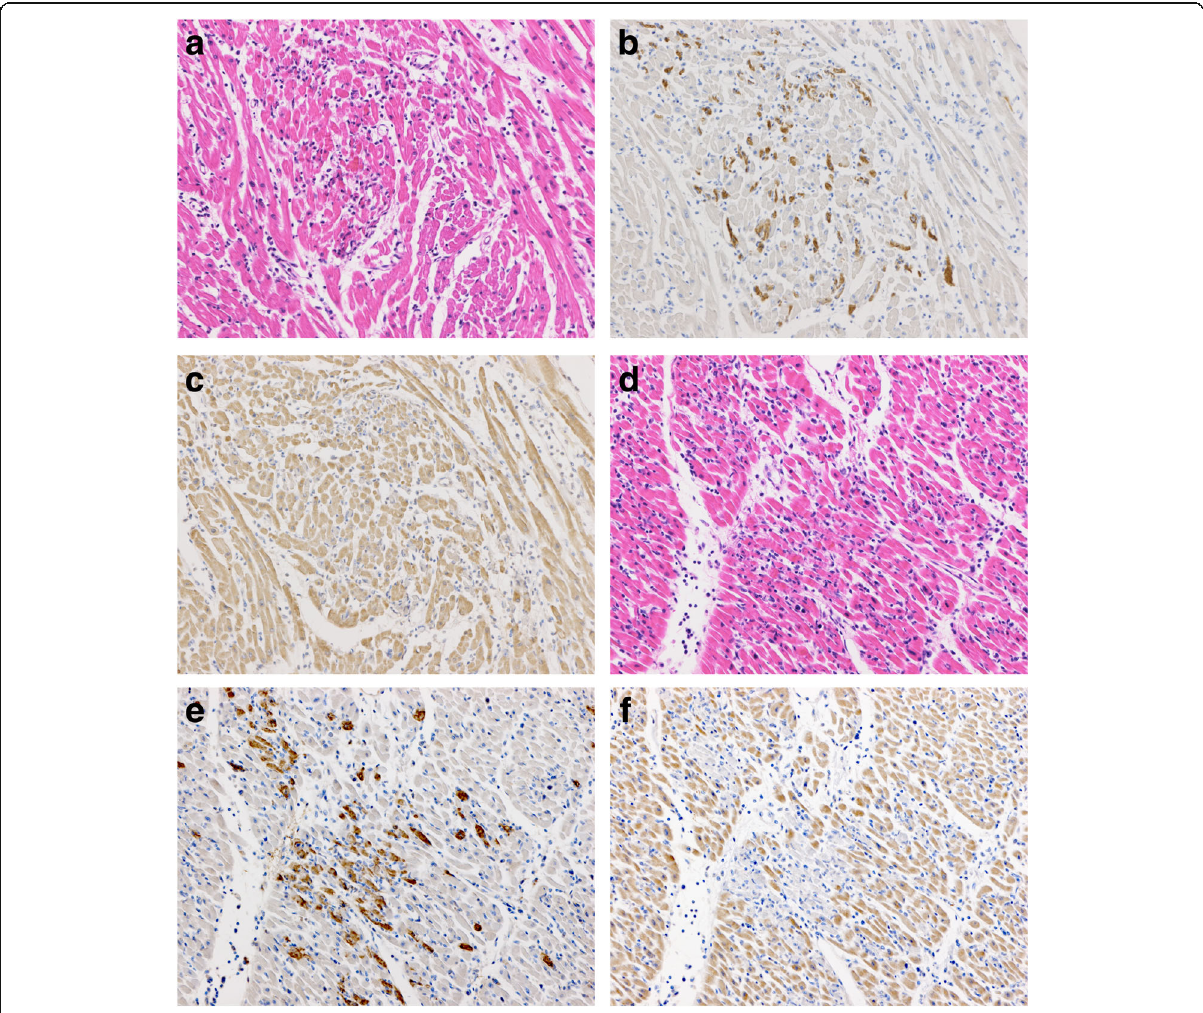
Fig. 2 Images of immunohistochemical staining in myocardial cells in case 1 ( a – c ) and case 2 ( d – f ). a , d Hematoxylin and eosin staining. b ,